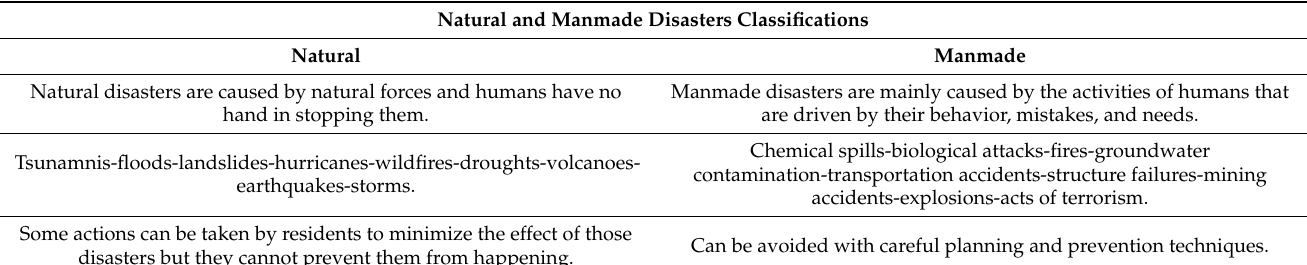
Table 1. Different natural and manmade disasters that can affect buildings. Adapted from [8].